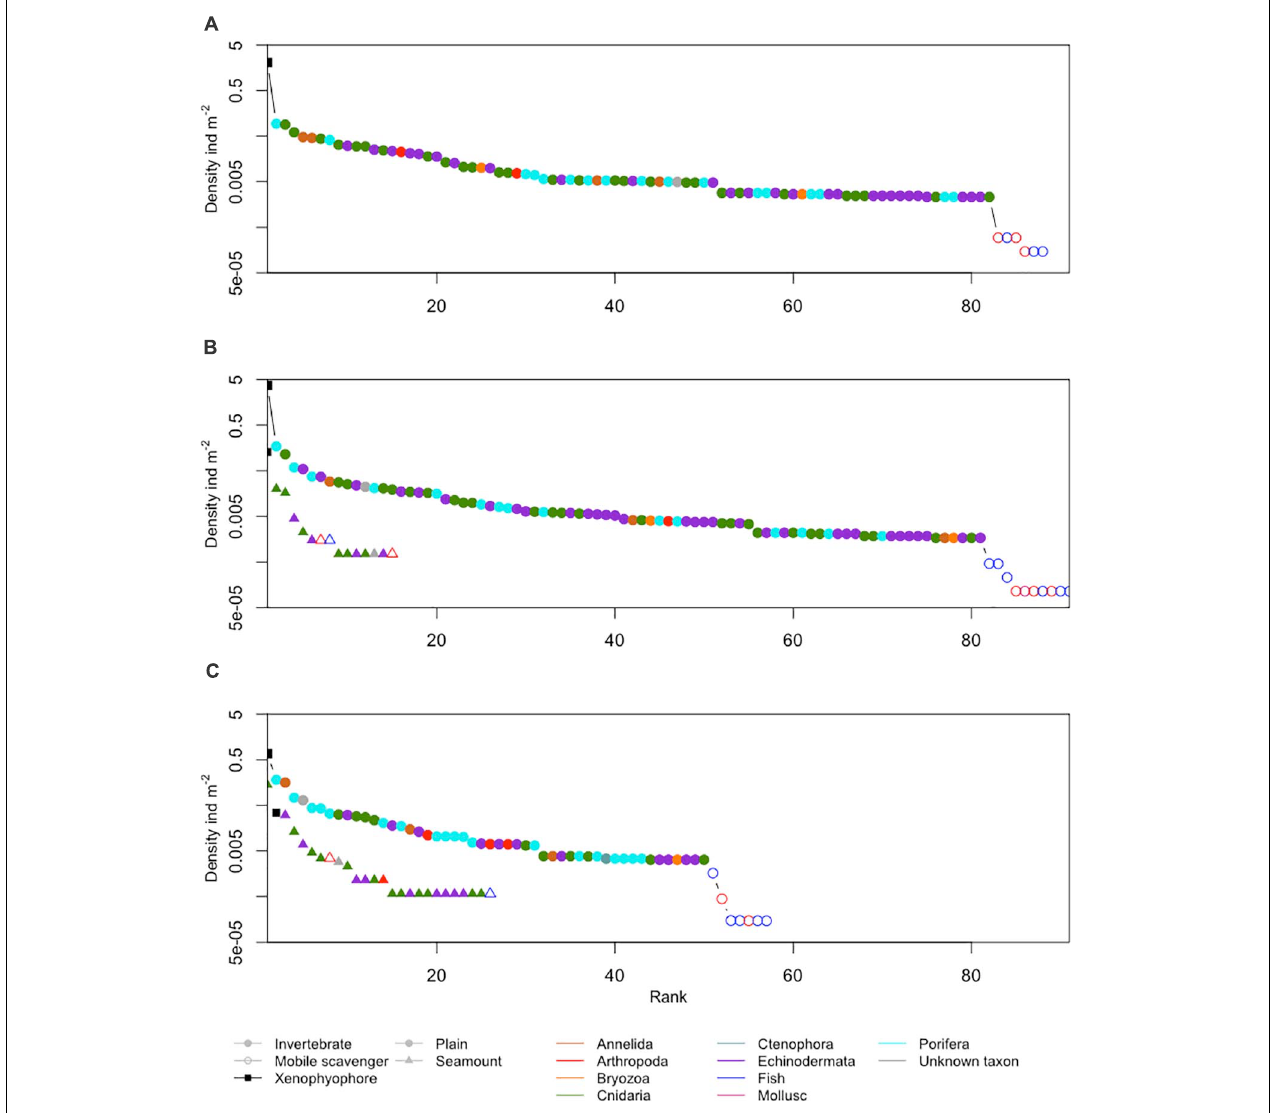
FIGURE 6 | Ranked densities of all seabed megafaunal morphotypes (metazoan invertebrates, highly mobile scavengers/predators, and xenophyophores) observed at (A) APEI-1, (B) APEI-4, and (C) APEI-7. Note the log scale in the y-axis.